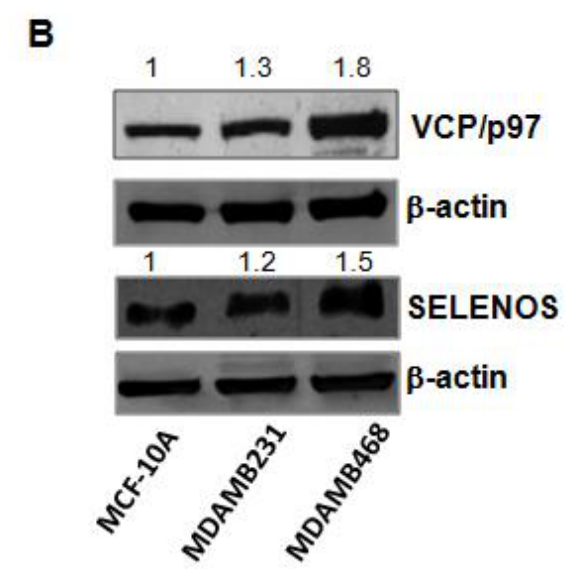
Figure 4. ( A ) Fold changes of expression levels for VCP/p97 mRNA in two TNBC cell lines (MDAMB468 and MDAMB231) compared to the non-cancerous MCF-10A cells, evaluated by the 2 − ∆∆ Cq method and reported as log 2 scale. We consider values higher than +1statistically significant. ( B ) Western blot validation of VCP/p97 and SELENOS expression on MCF-10A, MDAMB231 and MDAMB468 cell lines. β -actin was used as a loading control. The numbers indicate the quantifications performed for VCP/p97 and SELENOS by IMAGEJ software.